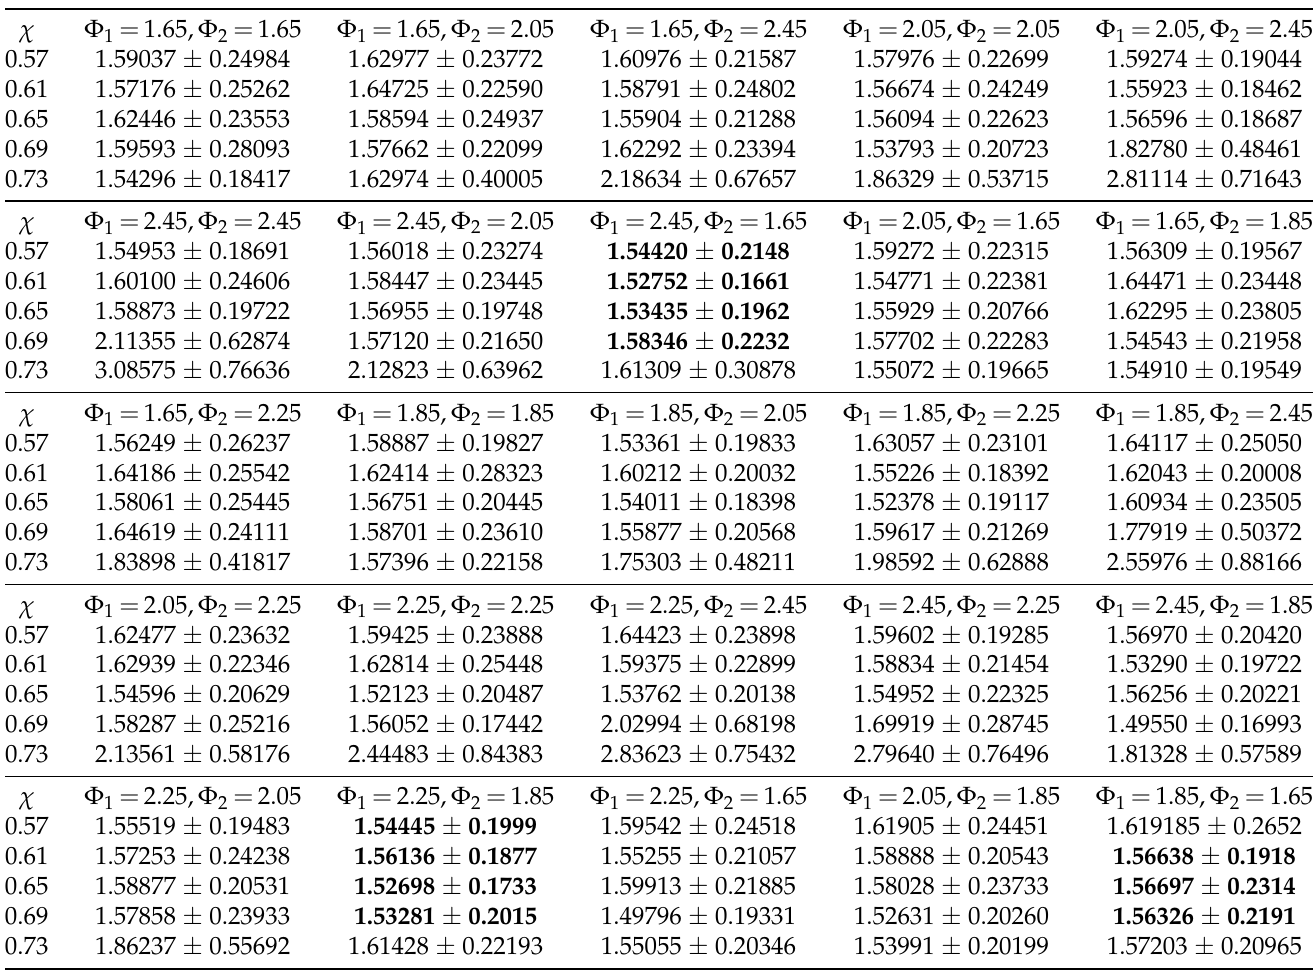
Table 4. The values of mean and standard deviation of f 4 obtained using PSO with I = 100, D = 80, (cid:96) = 12, n = 25 for 50 calculations with the metric d 1 .